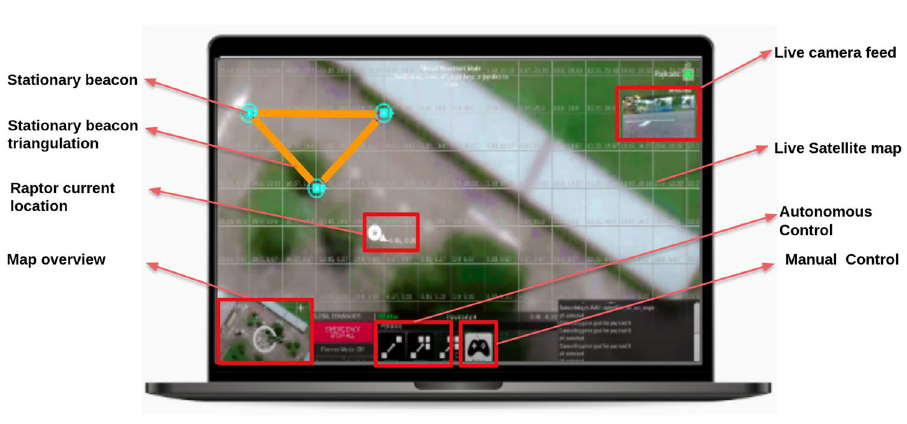
Figure 6. Operators control